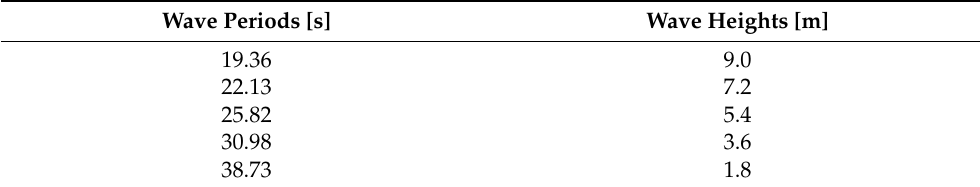
Table 3. Working conditions of waves.